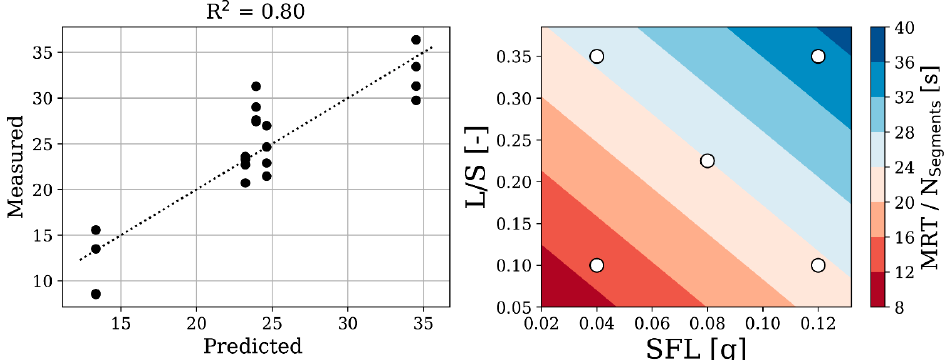
Figure 7. Left: Bilinear fit of MRT/N Segments (a = 123.46 s/g, b = 45.16 s, c = 3.89 s) with correlation plot between predicted and measured MRT/N Segments . Right: surface plot of predicted mean residence time (MRT) per repetitive screw segments. White dots indicate design space parameter combinations that determine predicted MRT for the correlation